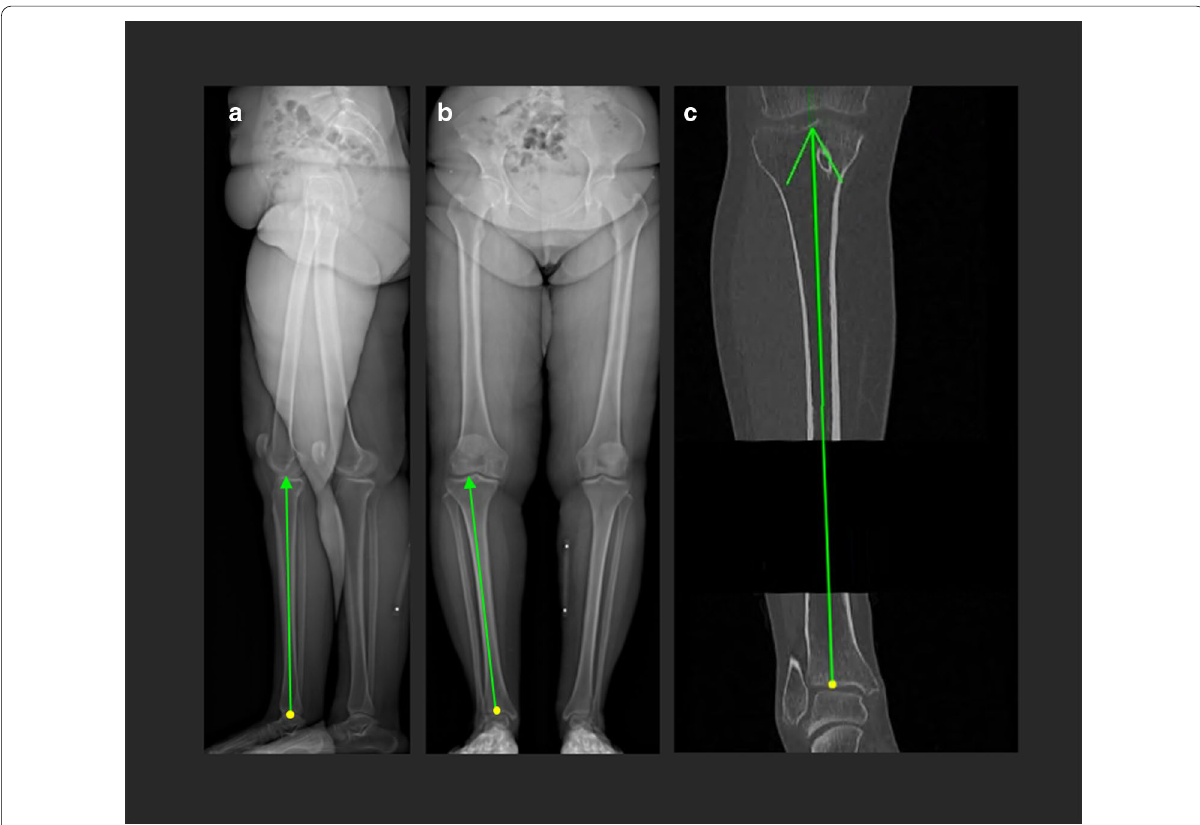
Fig. 3 Manual annotations to initialize the registration algorithm. Three user selected annotations are used to find the initial position between EOS and DRR. In this example, an arrow is drawn from the distal to the proximal end of the tibia in the two EOS images ( a , b ) as well as the CT scan ( c